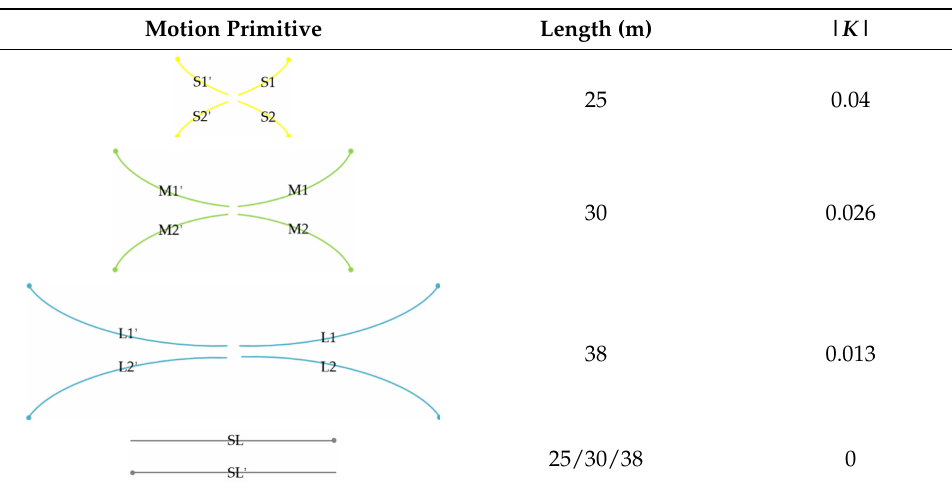
Table 3. Details of hybrid motion primitive